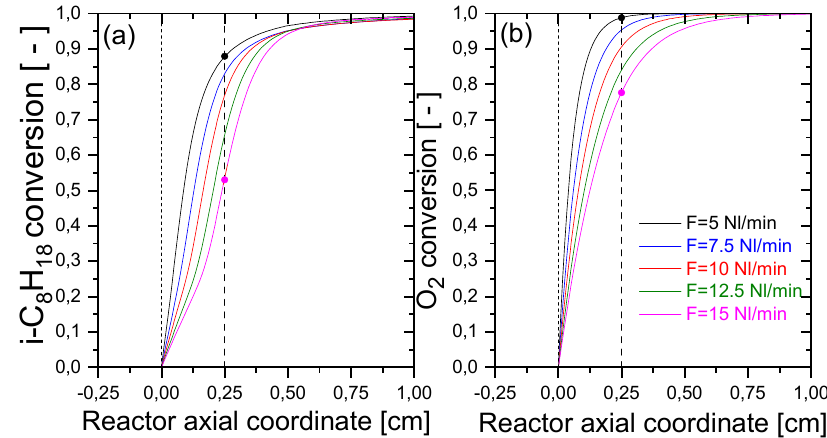
Figure 6. Effect of flow rate:( a ) i-C 8 H 18 conversion and ( b ) O 2 conversion. Feed composition: iC8 = 3%, air with C/O = 0.9 and N 2 complement.